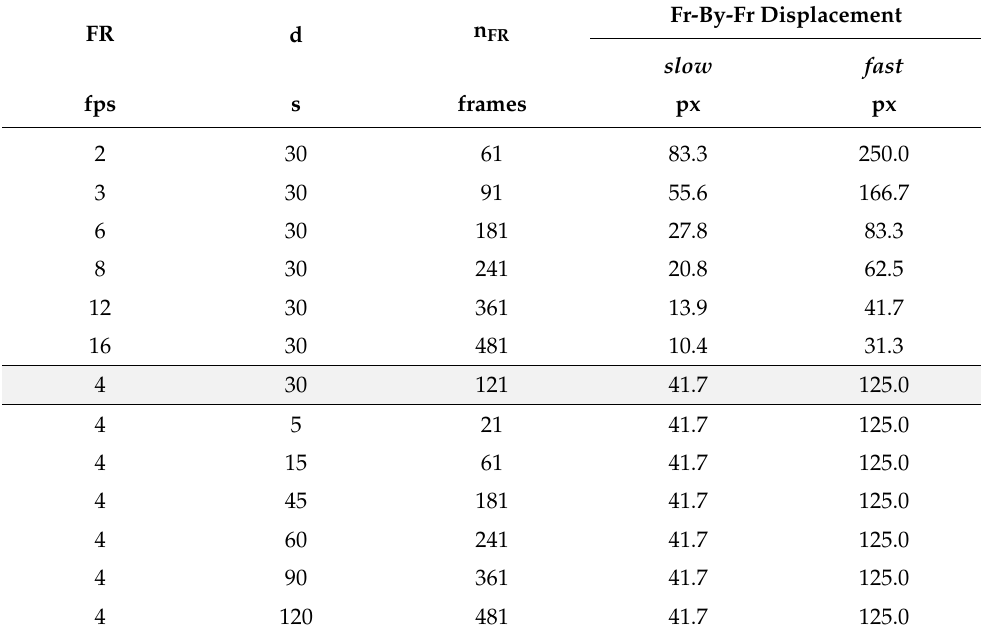
Table 2. Frame-rate (FR), sequence duration (d) and total number of processed frames (n FR ) for each scenario of the second set of simulations. The corresponding mean frame-by-frame tracer displacement (fr-by-fr displacement) with the imposed velocity profile for both slow (S) and fast (F) velocity case is also reported. The configuration with FR = 4 fps and d = 30 s (highlighted in grey) is common for both first analysis, with fixed duration and variable frame-rate, and second, with fixed frame-rate and variable duration, and it also that considered for the first set of simulations. Fr-By-Fr Displacement FR d n FR slow fast fps s